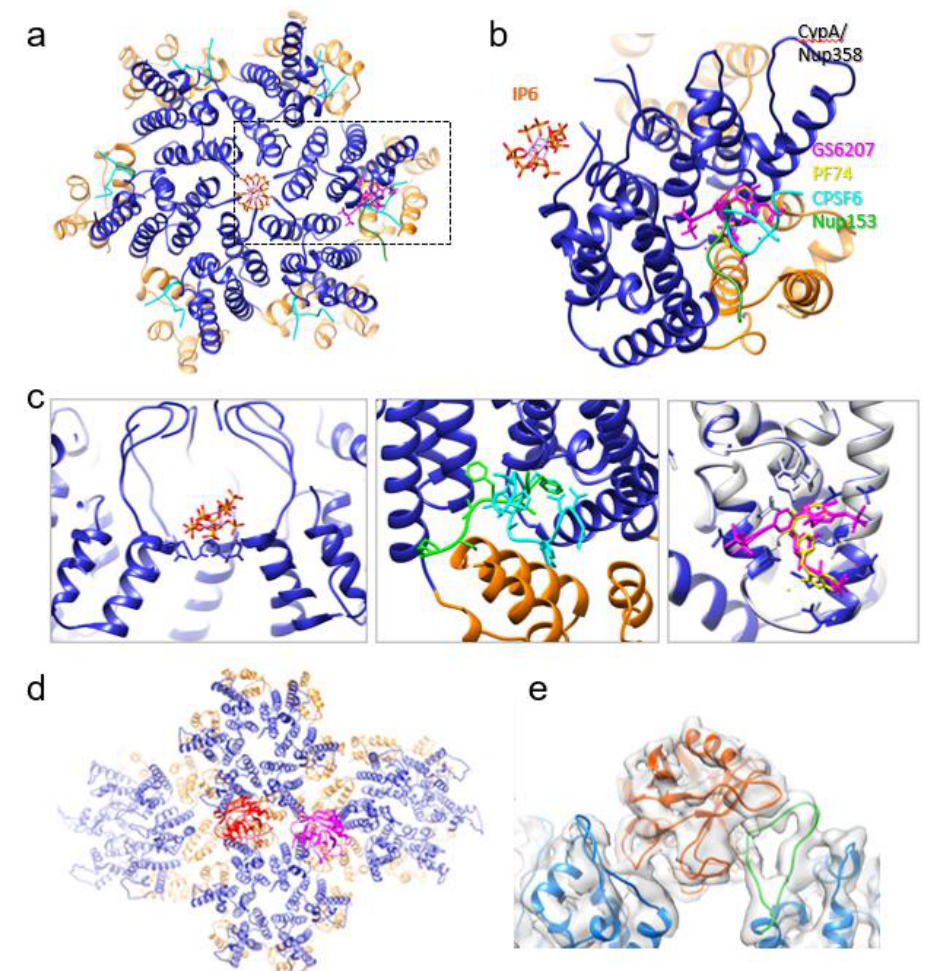
Figure 2. Interactions between HIV-1 capsid and host factors and small molecules. ( a ) Crystal structures of wild-type CA hexamer (PDB 4XFX) superimposed with IP6 (red), CPSF6 peptide (cyan), Nup153 peptide (green), PF74 (yellow) and GS6207 (pink). ( b ) An enlarged view of the boxed region in a. ( c ) Detailed interactions between capsid and IP6 (left) CPSF6/Nup153 (middle), PF74/GS6207 (right). ( d ) Interaction between CypA and capsid. Two CypA molecules (red and pink) can simultaneously bind to CA assembly above the dimer and trimer interface, respectively. ( e ) A side view CypA/CA complex, overlaid with the density map, above the dimer interface.